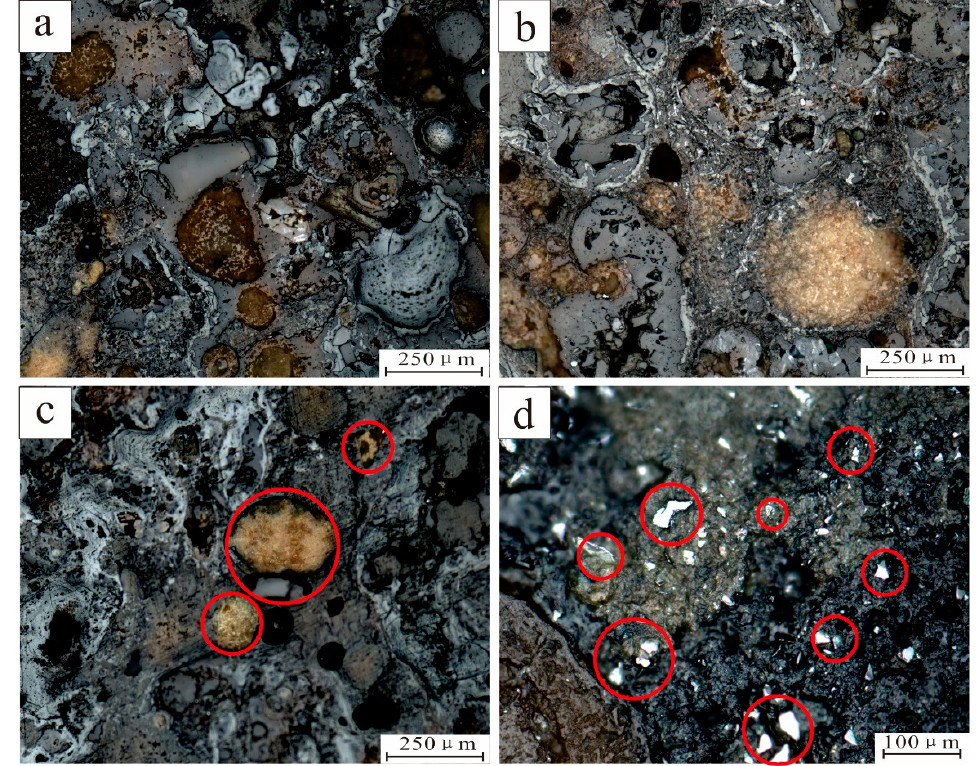
Figure 2. Mineral distribution and morphology of polymetallic nodules. ( a , b ) Distribution of terrigenous clast minerals in polymetallic nodules; ( c ) Feldspar particles (the red circle) from the core of polymetallic nodules; ( d ) Quartz mineral particles (the red circle) at the core of polymetallic nodules. Microstructures in the shell show certain regularities. Shells from the core to the edge present a detrital mineral content that initially decreased, and then increased, showing a loose to tight change. The microscopic structure was characterized by a loose shell near the nuclear division, mainly at the spot of mixed structure. The concentric spherical struc- ture, with a constant growth shell, evolves into the laminated structure, column structure,